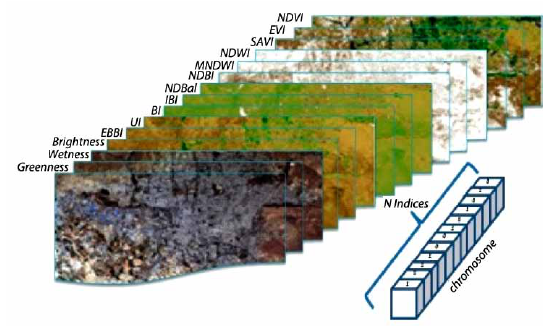
Fig. 2. Chromosome format in genetically feature